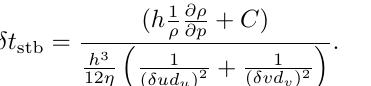
Figure 6: Pressure distribution after transient simula- tion of 10 revolutions, for incompressible lu- bricant and rigid